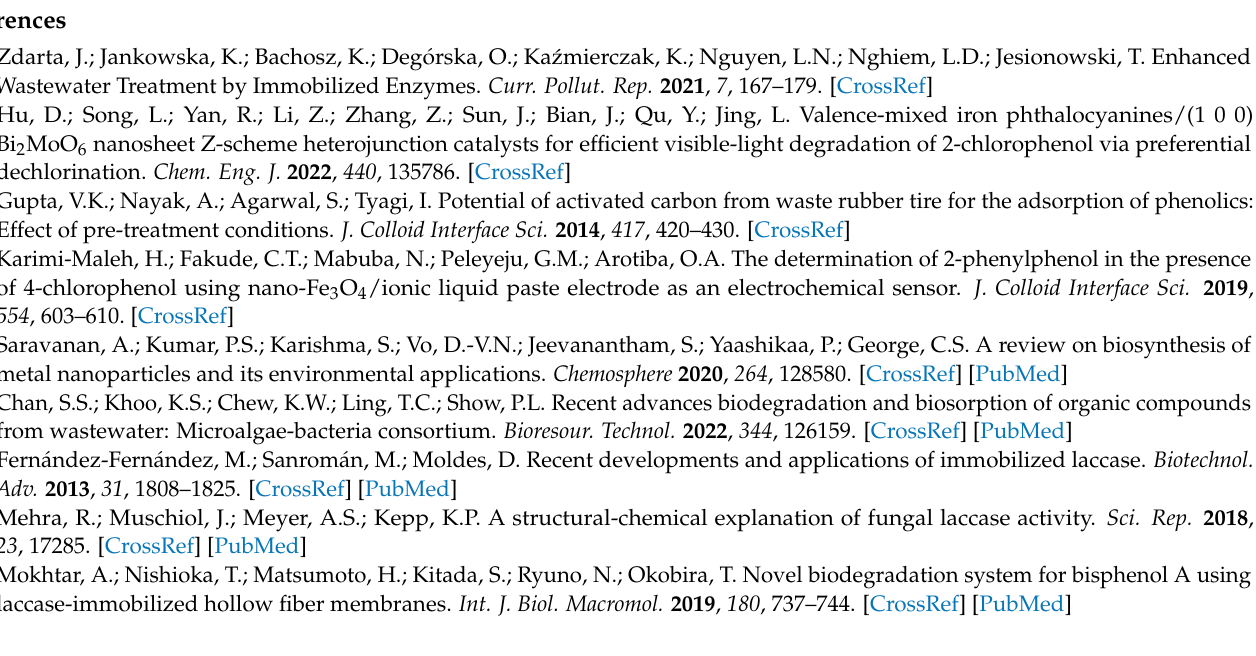
Figure S3: Effect of metal ions on laccase activity. Table S1: Different support enzyme loading performance and phenol compounds removal